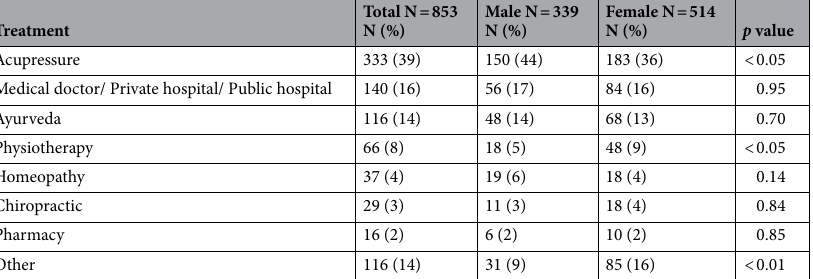
Table 6. Treatment received by subjects with low back pain (N = 853). N: Number of Subjects; %: Percentage.